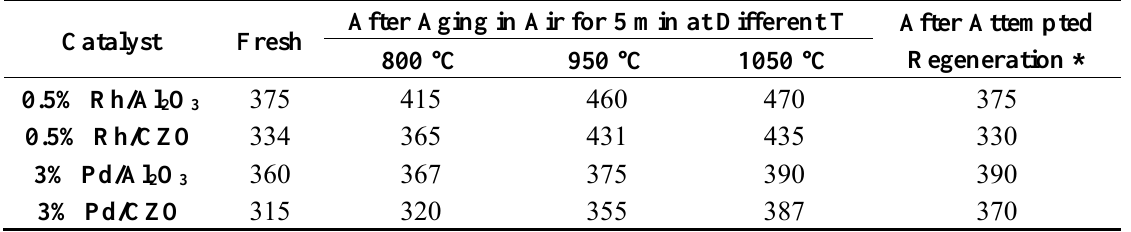
Table 1. T 50 s (°C) of fresh, aged, and attempted regenerated 3% Pd/Al 2 O 3 and 3% Pd/CZO, in comparison with 0.5% Rh/Al 2 O 3 and 0.5% Rh/CZO as reported in Part I.